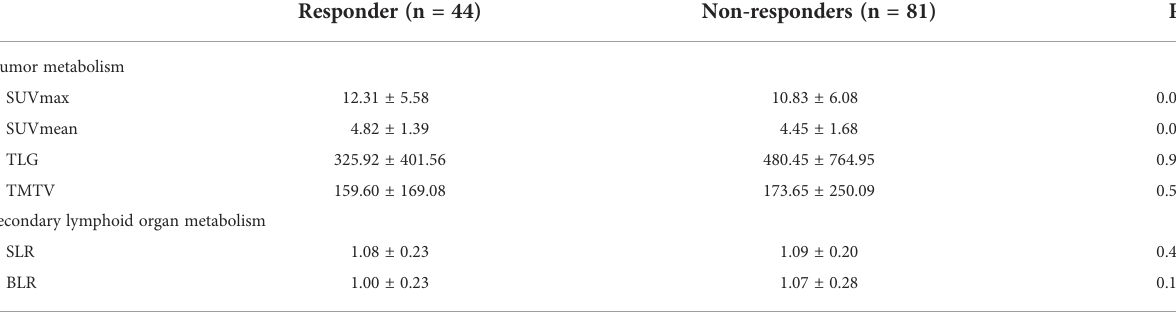
TABLE 2 Comparison of pretreatment PET/CT metabolic parameters between response groups.